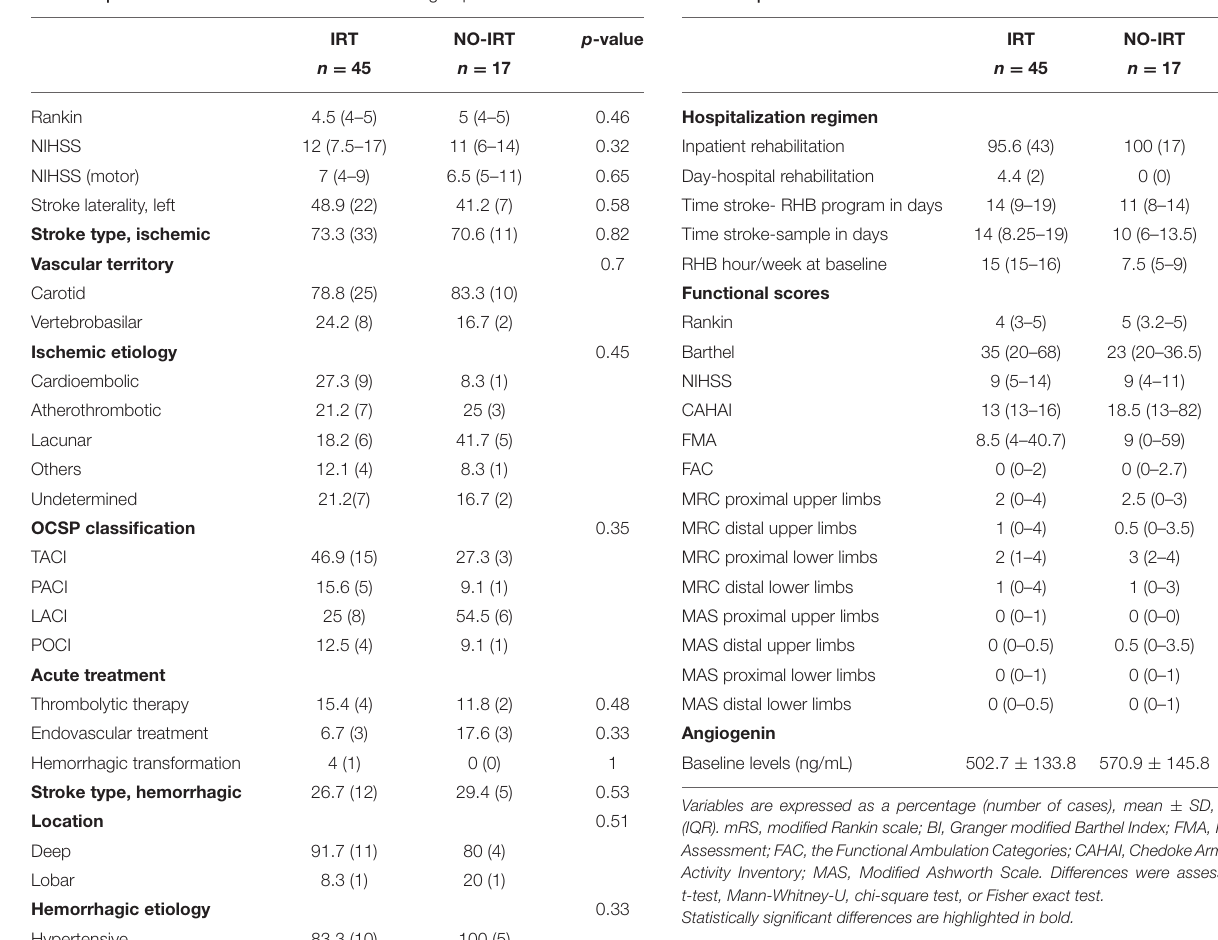
Variables are expressed as a percentage (number of cases), mean ± SD, or median (IQR). mRS, modified Rankin scale; BI, Granger modified Barthel Index; FMA, Fugl-Meyer Assessment;FAC,theFunctionalAmbulationCategories;CAHAI,ChedokeArmandHand Activity Inventory; MAS, Modified Ashworth Scale. Differences were assessed with a t-test, Mann-Whitney-U, chi-square test, or Fisher exact test. Statistically significant differences are highlighted in